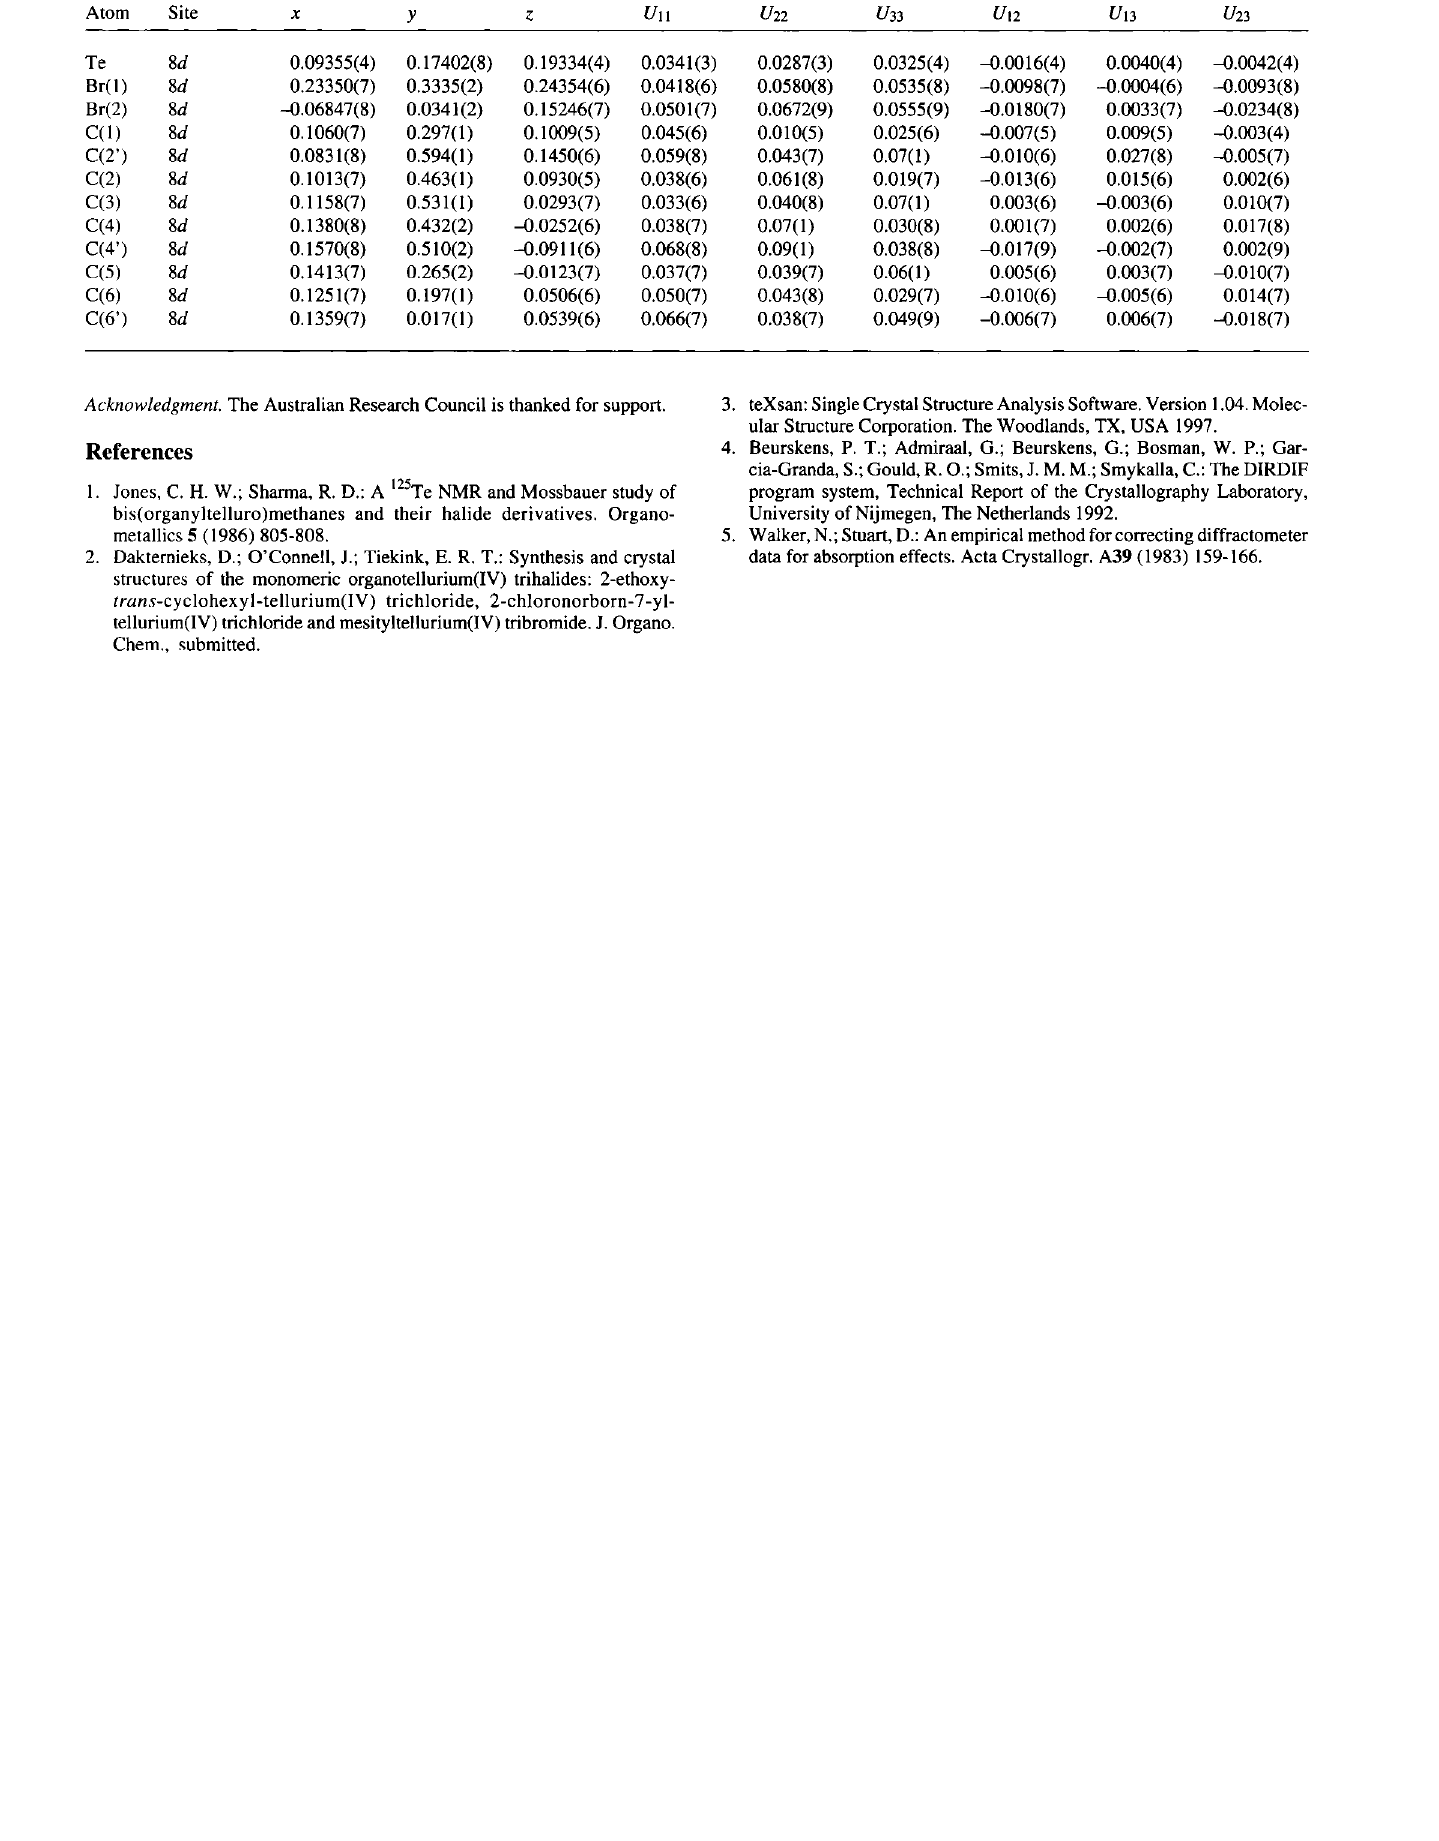
Table 3. Atomic coordinates and displacement parameters (in Ä 2